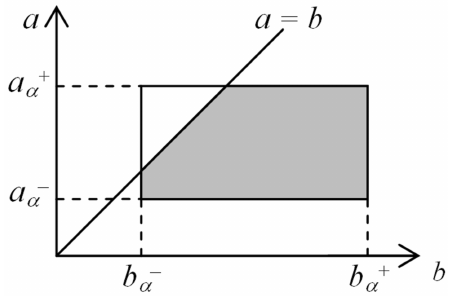
Figure 7. Geometrical interpretation of probabilistic α -cuts